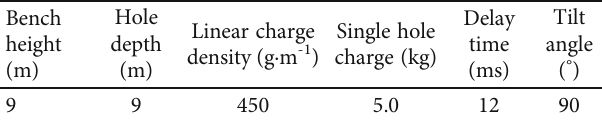
Figure 4: Air interval charging. Table 3: Presplitting blasting